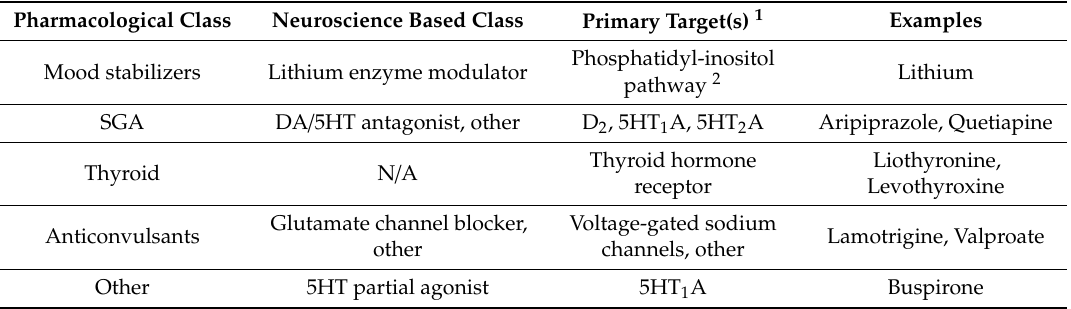
Table 2. Pharmacological Classes of Augmentation Agents for